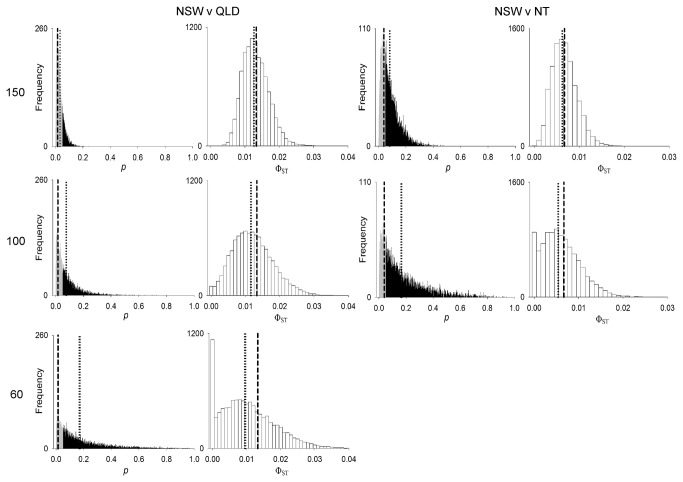
Pairwise Φst and p value distributions following random re-sampling simulations.NSW versus QLD and NT pairwise distributions based on 10,000 replicate random re-samples of the NSW population at n = 150, 100 and 60. Grey and black zones on p value distributions represent p ≤ 0.05 and p > 0.05 respectively. Dotted lines denote upper and lower 95% confidence intervals around sample means. Dashed lines indicate pairwise ΦST and p values generated by the original analysis.